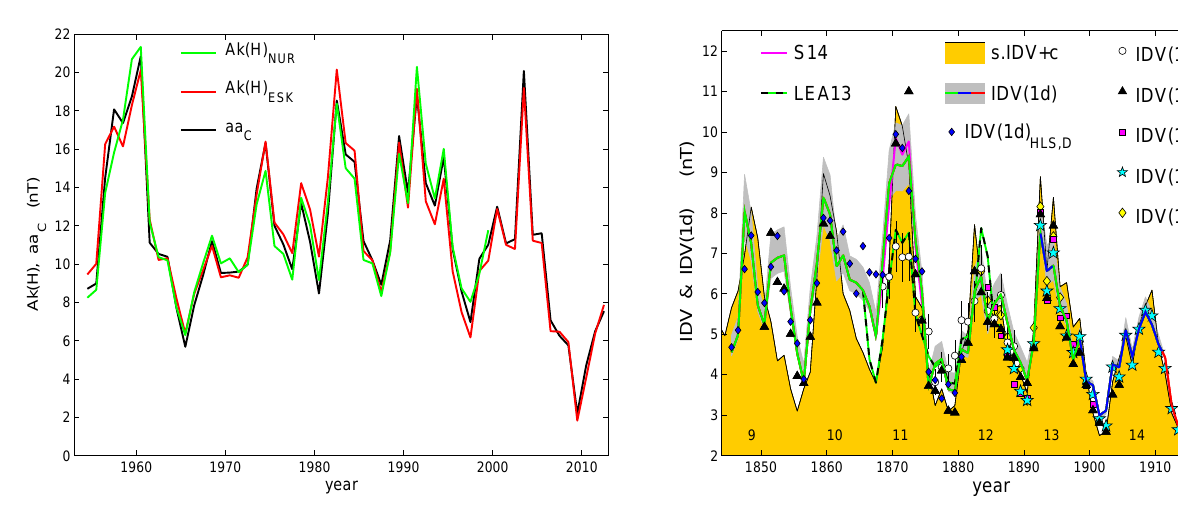
Fig. 6. Revised version of Fig. 14 of Lockwood et al. (2013a) (Pa- per 1). Annual means of the IDV(1d) composite are shown with data originating from ESK in red, NGK in blue and HLS in green, surrounded by a grey area showing the band of uncertainty that arises from the two regression fits. The HLS data shown by the green line have been corrected in cycle 11 as discussed in the text. The black line bounding the filled orange area is the IDV index, scaled using the regression for the period 1880–2013, as shown in Fig. 12 of Lockwood et al. (2013a). IDV(1d) derived from vari- ous early data sets are also shown: from St Petersburg, IDV(1d) SPE (black triangles); from Ekaterinburg, IDV(1d) EKA (cyan stars); from Parc St Maur, IDV(1d) PSM (mauve squares); from Wil- helmshaven, IDV(1d) WLH (yellow diamonds); and from Green- wich, IDV(1d) GRW (white circles). The blue diamonds are derived using the D component observed at Helsinki, IDV(1d) HLS ,D . The Greenwich values are compiled using the daily means of H that are uncorrected for temperature variations, with annual IDV(1d) GRW means subsequently corrected (giving the shown uncertainty bands caused by the temperature effects). Solar cycle numbers are shown across the base of the figure. The green-and-black dashed line in Fig. 6 is the variation of IDV(1d) derived Paper 1 from the un- corrected Helsinki magnetometer data. The mauve line shows the data series with the 30% upward recalibration for the period 1866– 1874.5 derived by Svalgaard